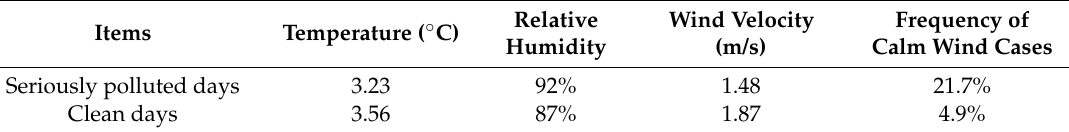
Table 2. Average ground meteorological element during seriously polluted cases and clean